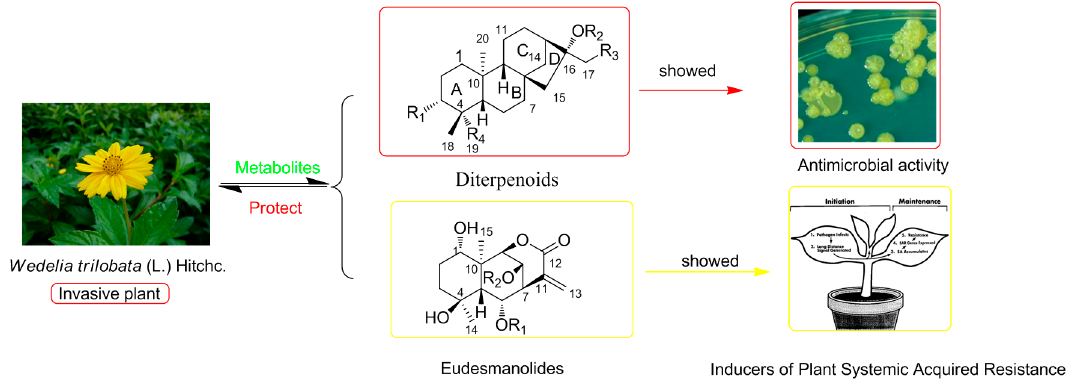
Figure 3. The correlations between Wedelia trilobata and its metabolites.